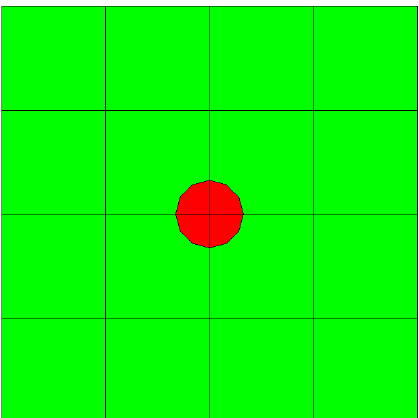
Figure 1. Scale 6.1 single pin cell geometry. The 3.5106 cm diameter uranium slug is shown at the center of the 22 cm pitch. The entire area outside of the fuel slug is modeled as